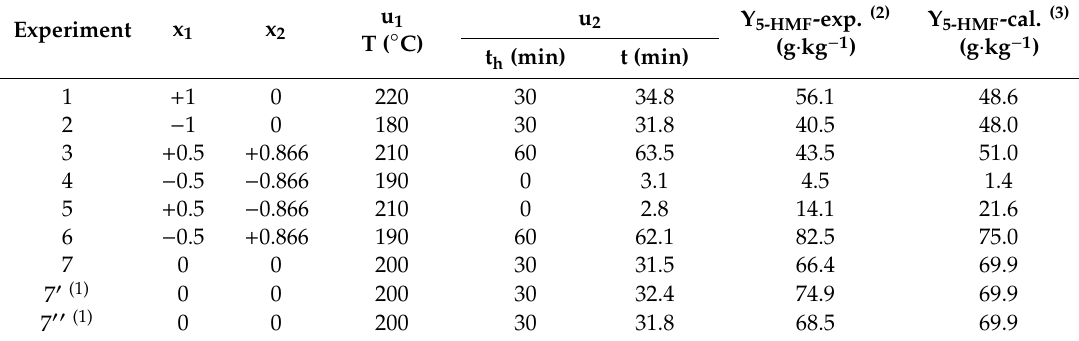
Table 1. Doehlert matrices with e ff ective (u i ) and normalized (x i ) variables and values of